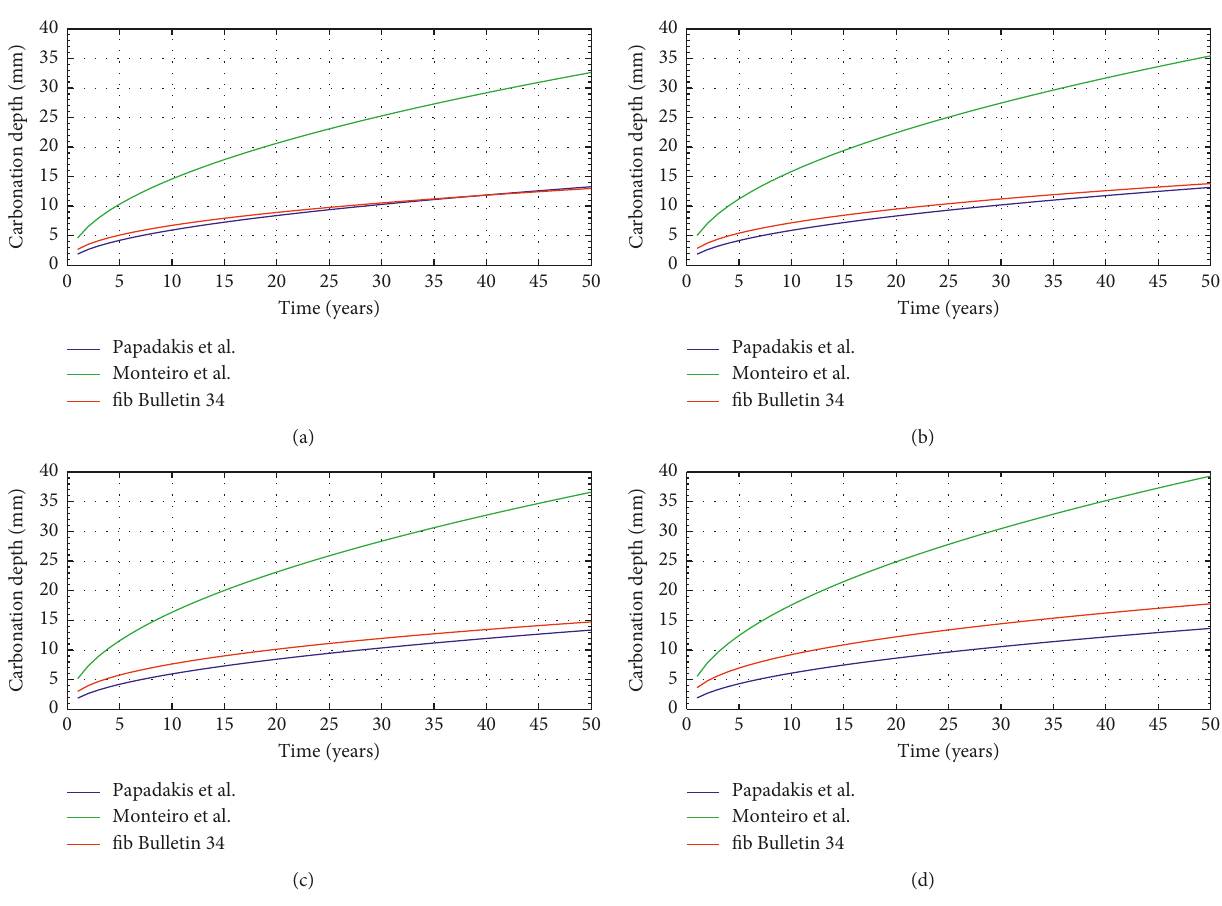
Figure 5: Comparison between models’ prediction of carbonation depth versus service life: XC1 exposure class: w/c � 0.65. (a) R � 0%; (b) R � 20%; (c) R � 50%; (d) R �